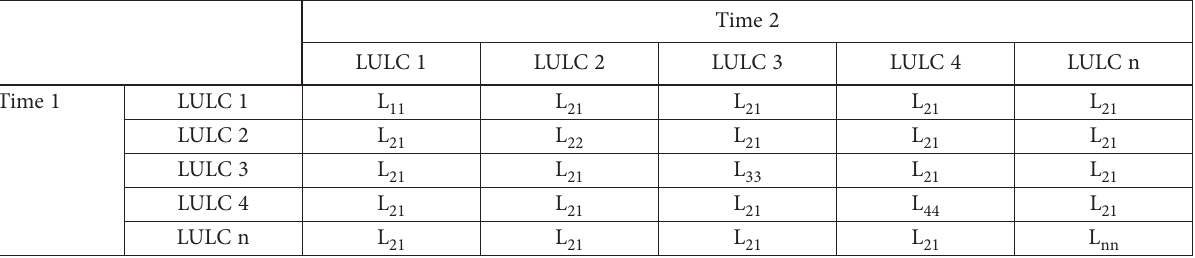
Table 1. Transition matrix (source: by the